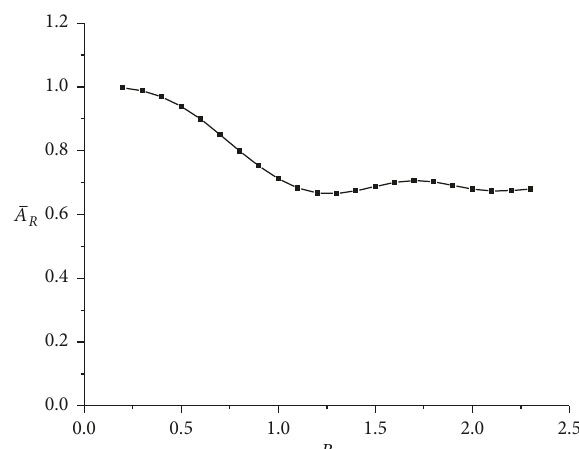
Figure 5: Variation curve of the average amplitude attenuation ratio of ground displacement with